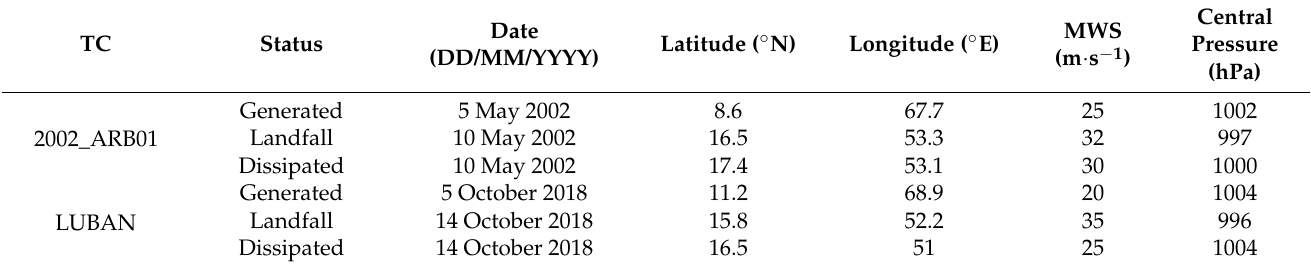
Table 1. TC status, time, position, intensity, central pressure, and maximum wind speed is